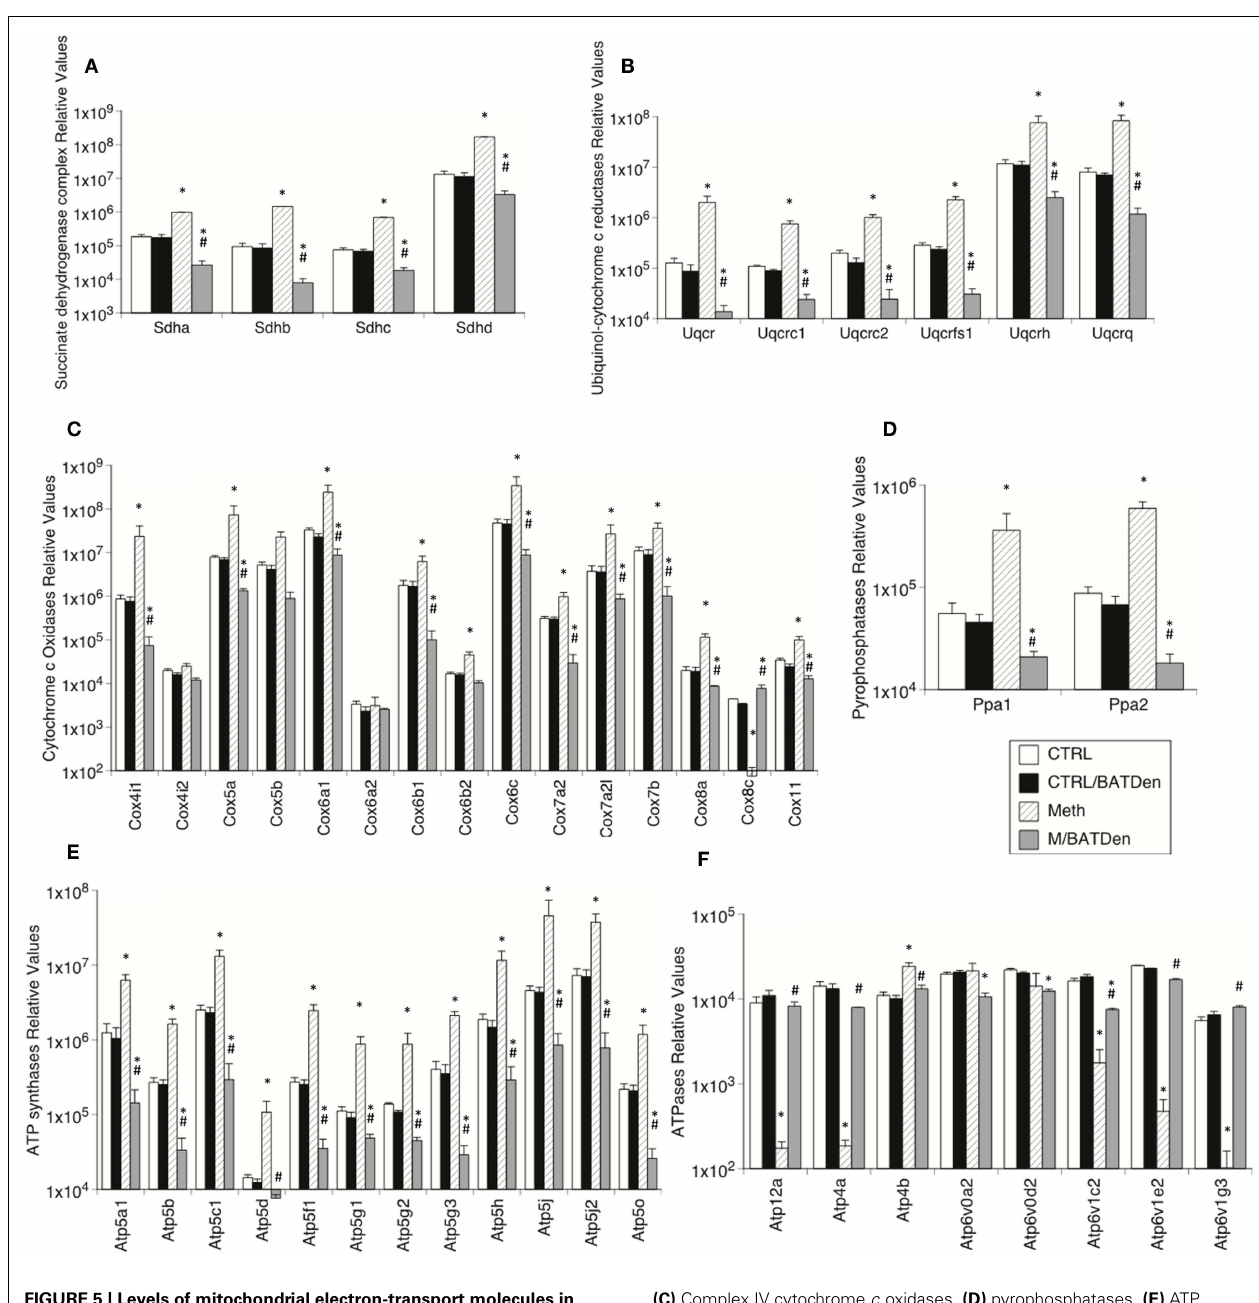
FIGURE 5 | Levels of mitochondrial electron-transport molecules in BAT from animals injected with Methamphetamine. Transcriptional enzymes were measured by SyBrGreen qRT-PCR. Relative values were normalized based on GAPDH. Levels of (A) Complex II succinate dehydrogenases, (B) Complex III ubiquinol-cytochrome c reductases,